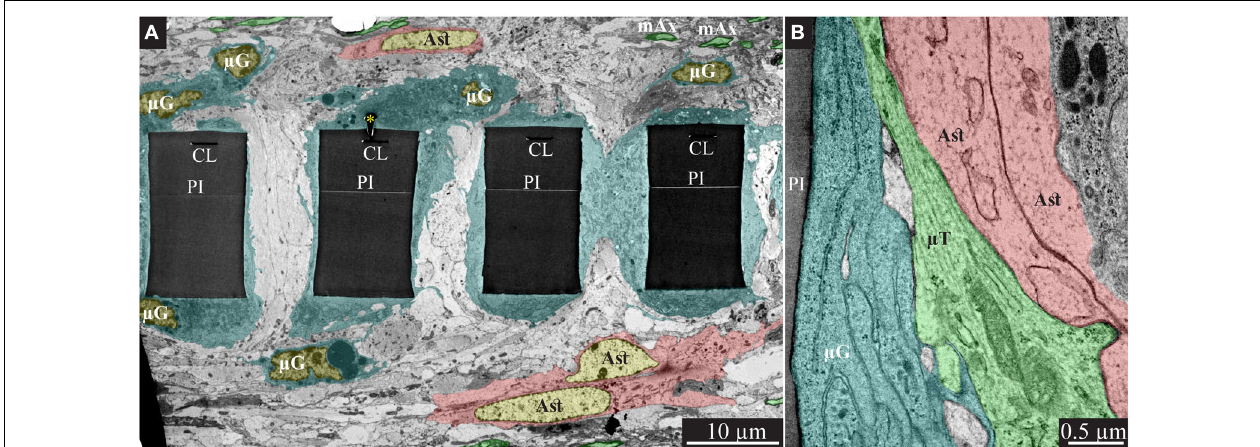
FIGURE 3 | Encapsulation of individual PPMPs “ribs” by adhering microglia. (A) A low magnification transmission electron microscope cross-section of an implanted PPMP along with the parenchyma around it 2 weeks after platform implantation. The PI “ribs” are encompassed by microglia (cytoplasm marked in cyan and typical microglia nuclei µ G -yellow) and astrocytes (cytoplasm marked pink, and astrocyte nuclei Ast- yellow). (B) Microglia adhering to the PI surface interposed between the implant and non-myelinated neurites containing microtubules and astrocyte branches that invaded the platform pores. No myelinated axons were seen in the immediate vicinity of the implant at this point in time after PPMP implantation. PI, polyimide ribs; gM µ E, yellow asterisks, mAx- myelinated axons (green); CL, conducting line; µ G, microglia; µ T, microtubule; Ast, astrocyte. Note that an unmarked copy of this figure is presented as Supplementary Figure 3 .